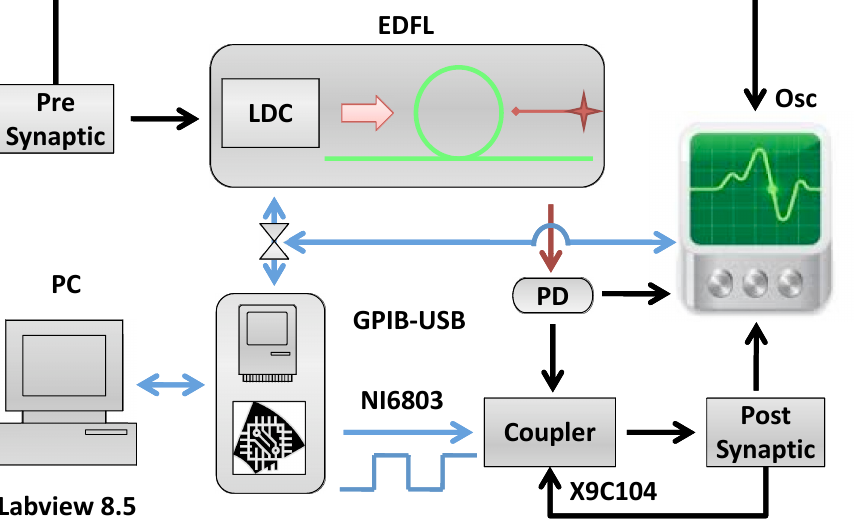
Figure 1. Experimental setup. The pre-synaptic FitzHugh–Nagumo (FHN) electronic circuit drives the erbium-doped fiber laser (EDFL) via the laser diode controller (LDC). post-synaptic FHN electronic circuit. The output signals from the pre-synaptic